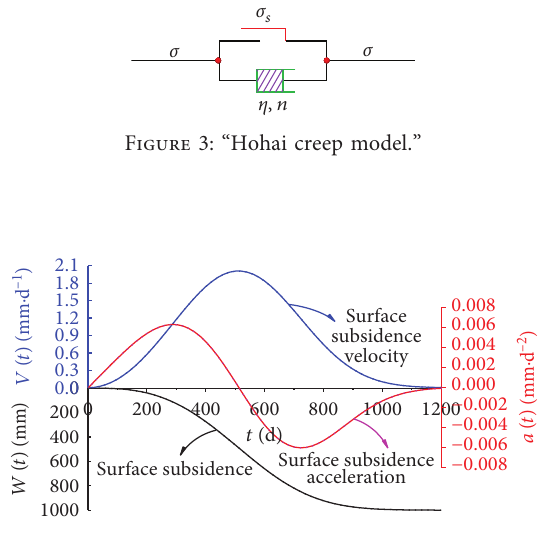
Figure 4: Subsidence, subsidence velocity, and subsidence acceleration curve of improved Knothe